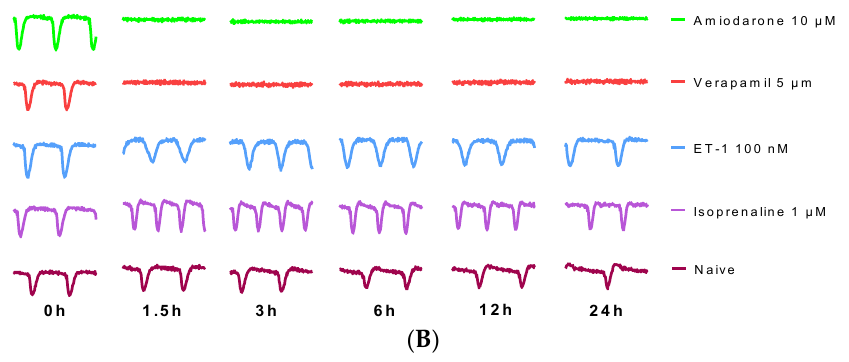
Figure 2. Representative contraction profiles of ( A ) rat neonatal CMs and ( B ) hiPS-CMs treated by reference compounds. Data were presented as mean ± SD, n = 3.